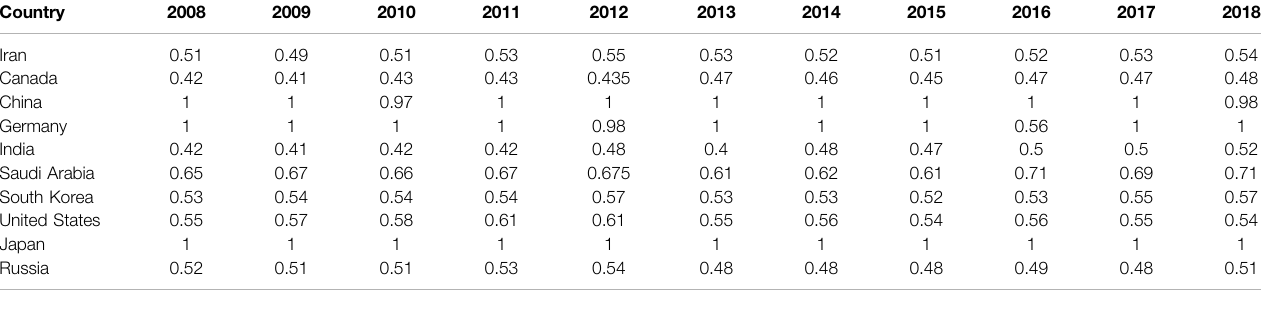
TABLE 4 | Energy ef fi ciency score.